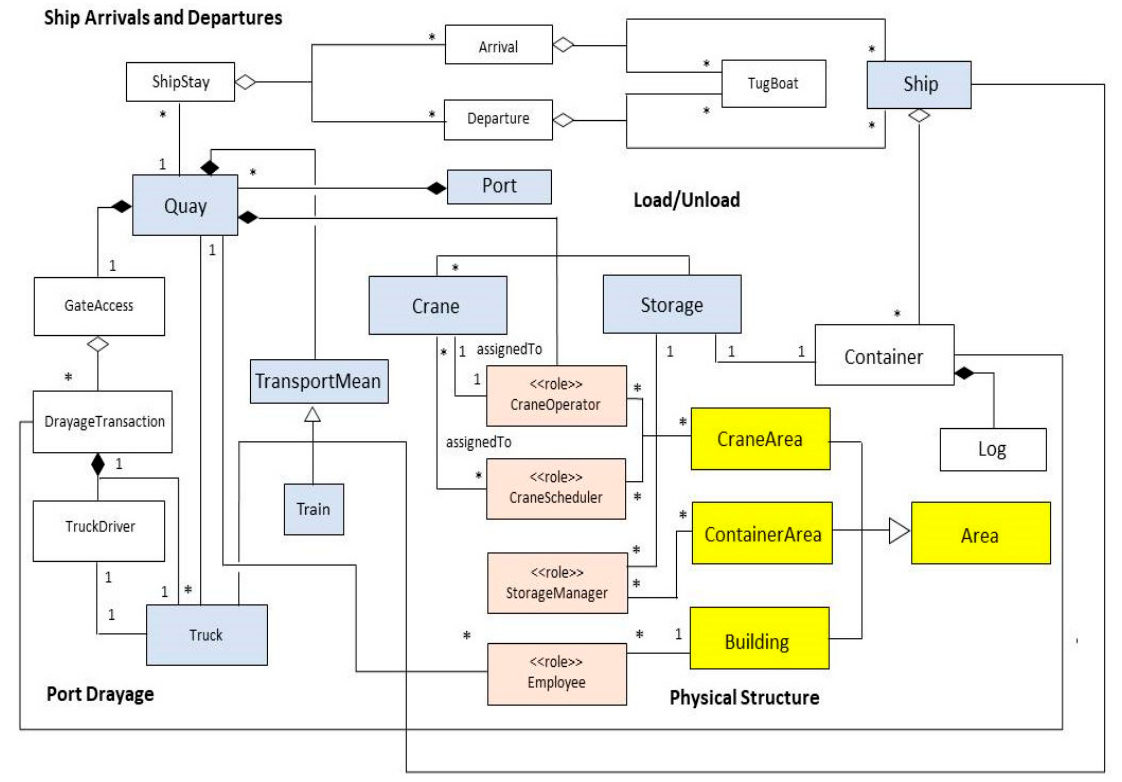
Figure 13. Partial reference architecture for a cargo port.